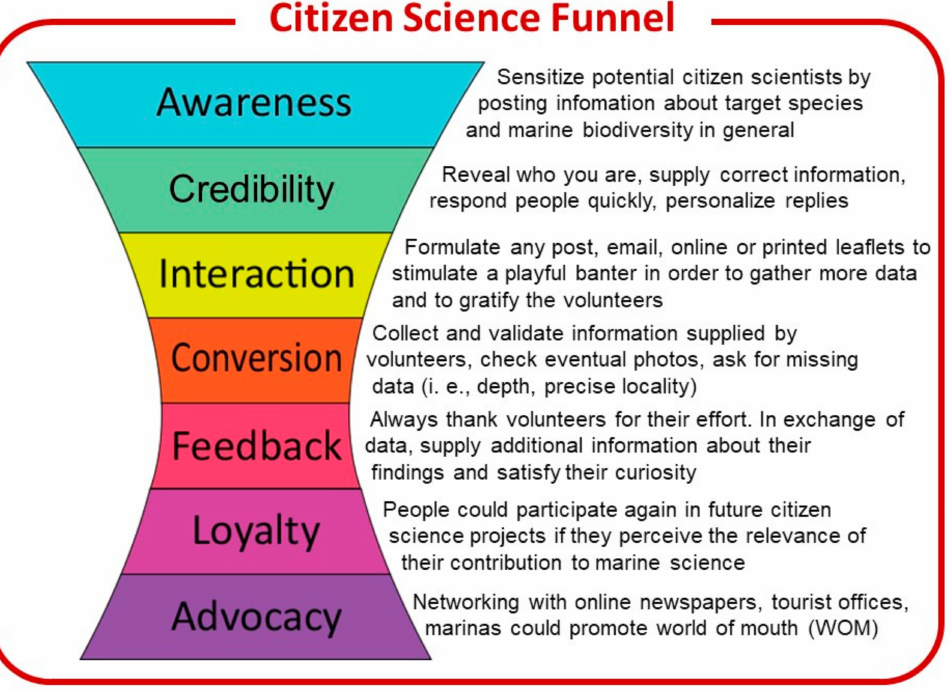
Figure 8. Citizen science funnel illustrating phases leading to conversion (i.e., engagement of citizen